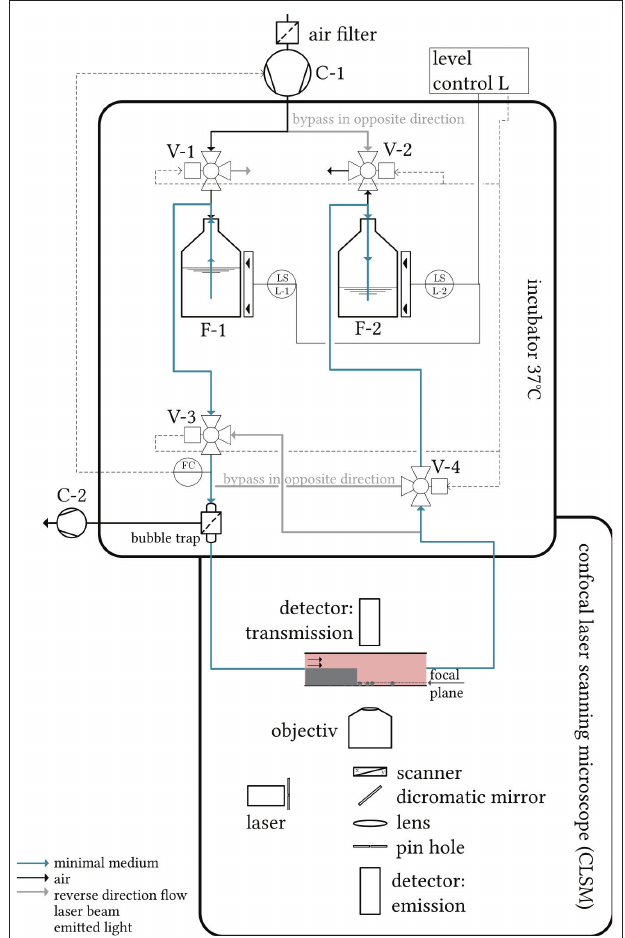
FIGURE 3 | Schematic representation of the measurement setup. Tempered minimal medium is pumped alternately through the flow chamber (light-pink) via a compressor between two bottles. The flow chamber is mounted on a confocal laser scanning microscope, which focuses a laser beam on the sample probe. Both the laser transmission and the emitted light of excited fluorophores in the sample are detected in separate detector units in order to assess the local biomass and the local fluorophore density,